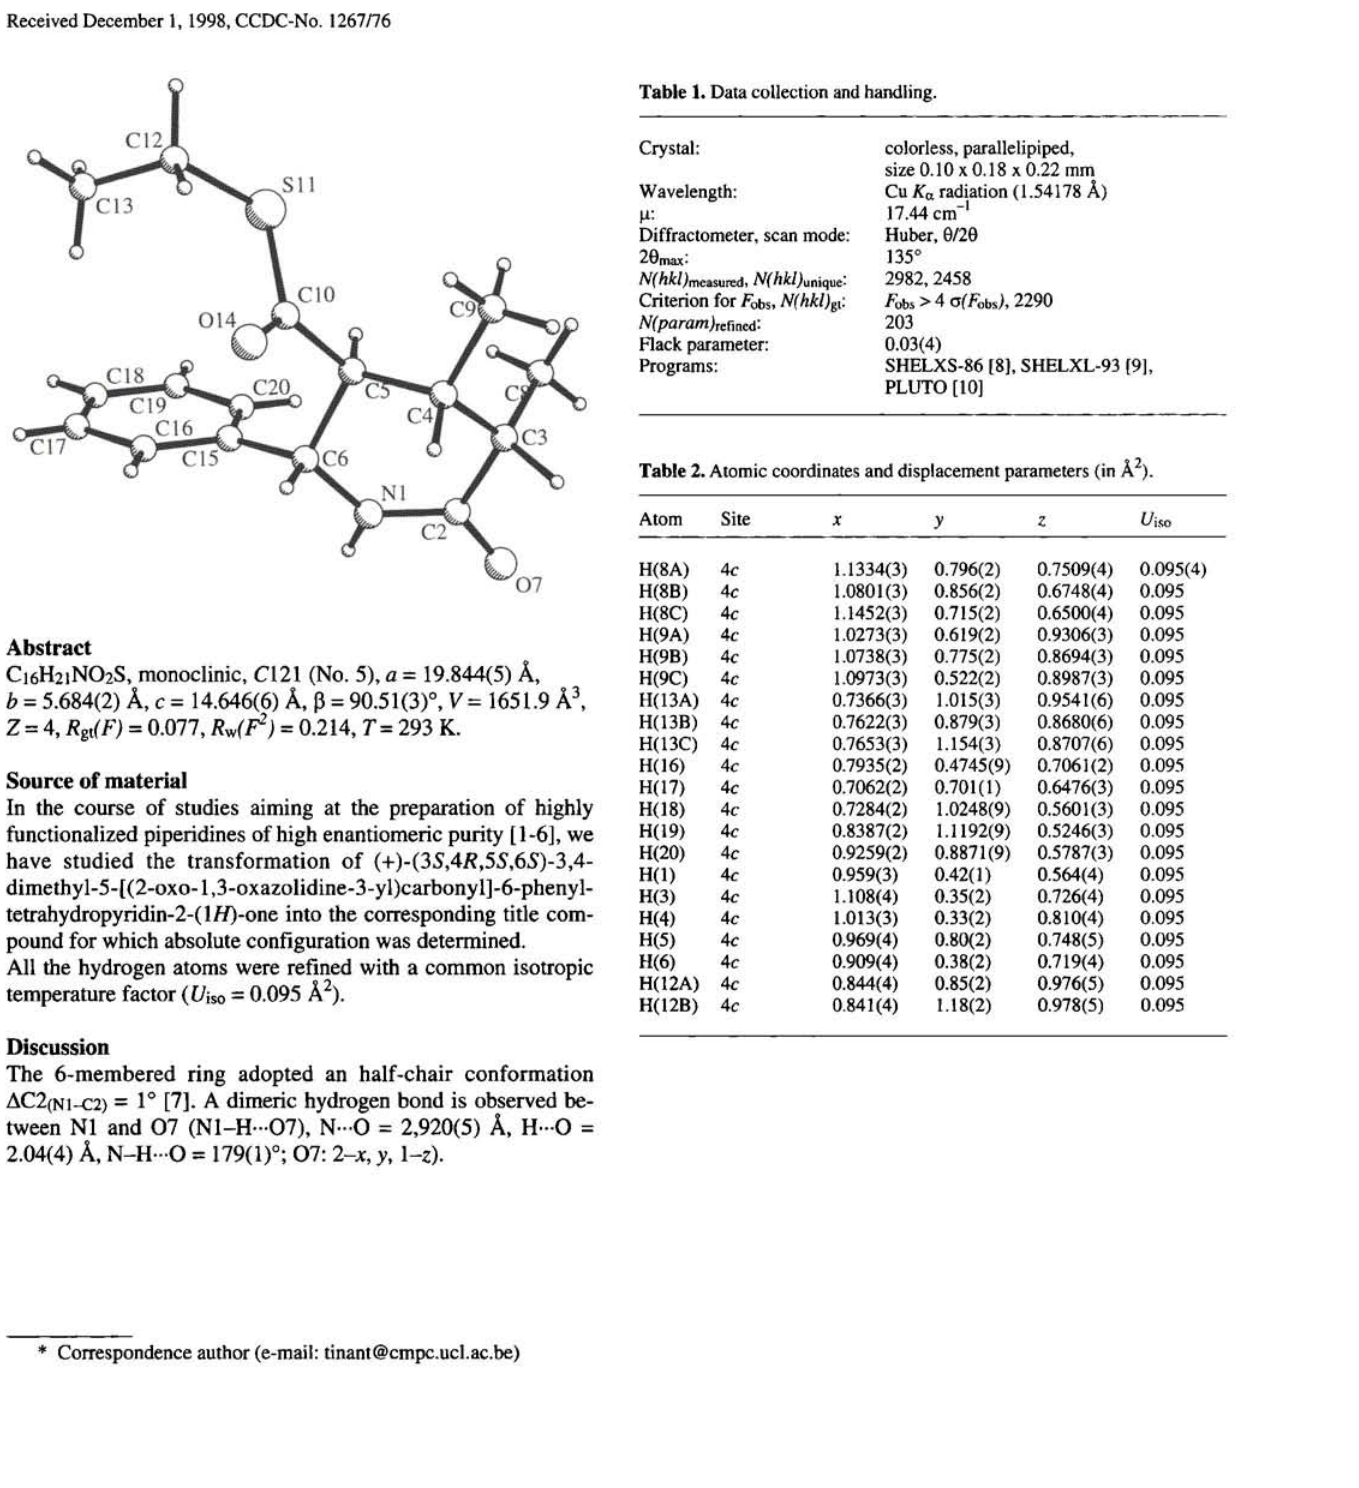
Table 1. Data collection and handling.